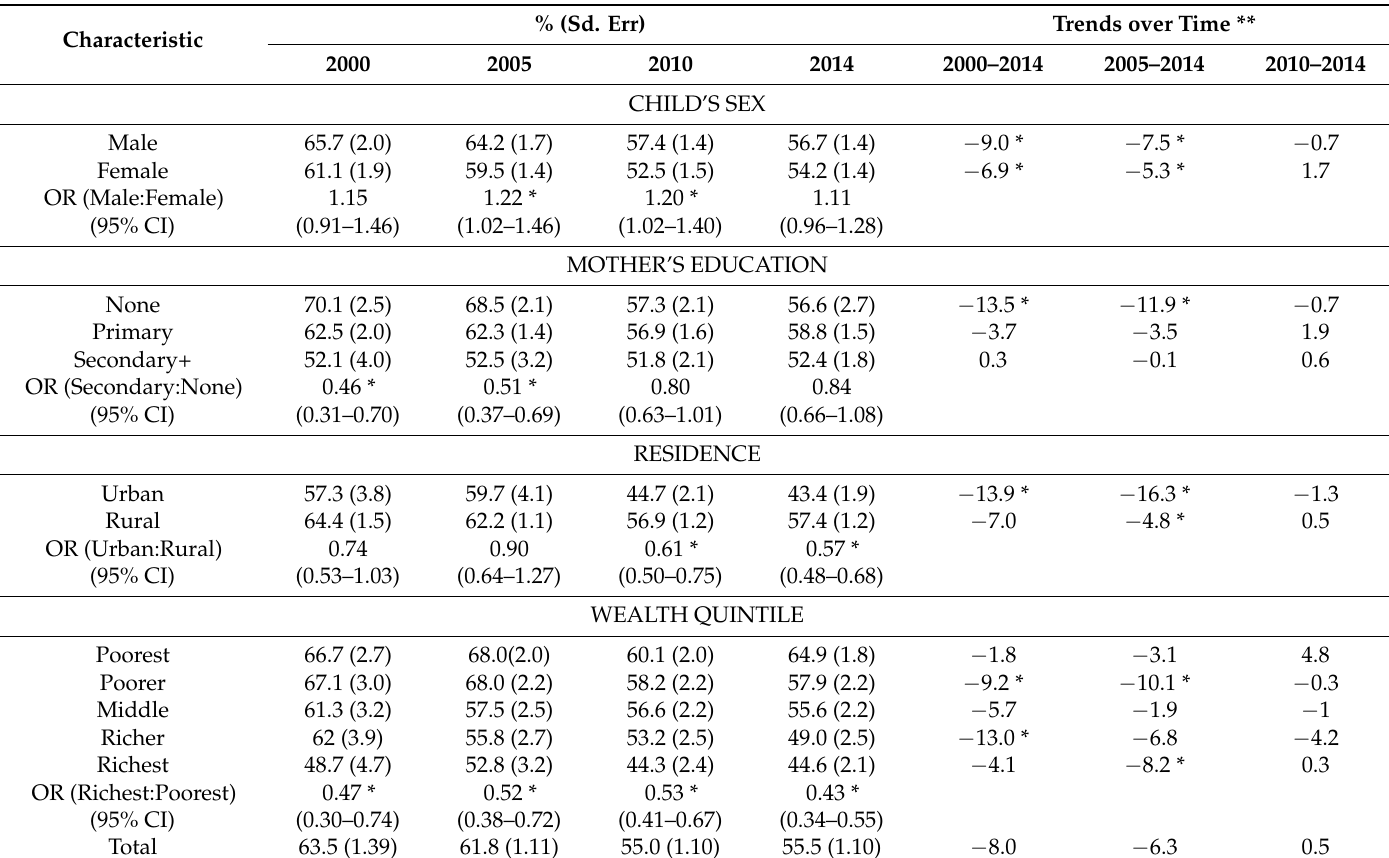
Table 6. Prevalence of anemia in children in the four surveys according to their social characteristics. % (Sd. Characteristic